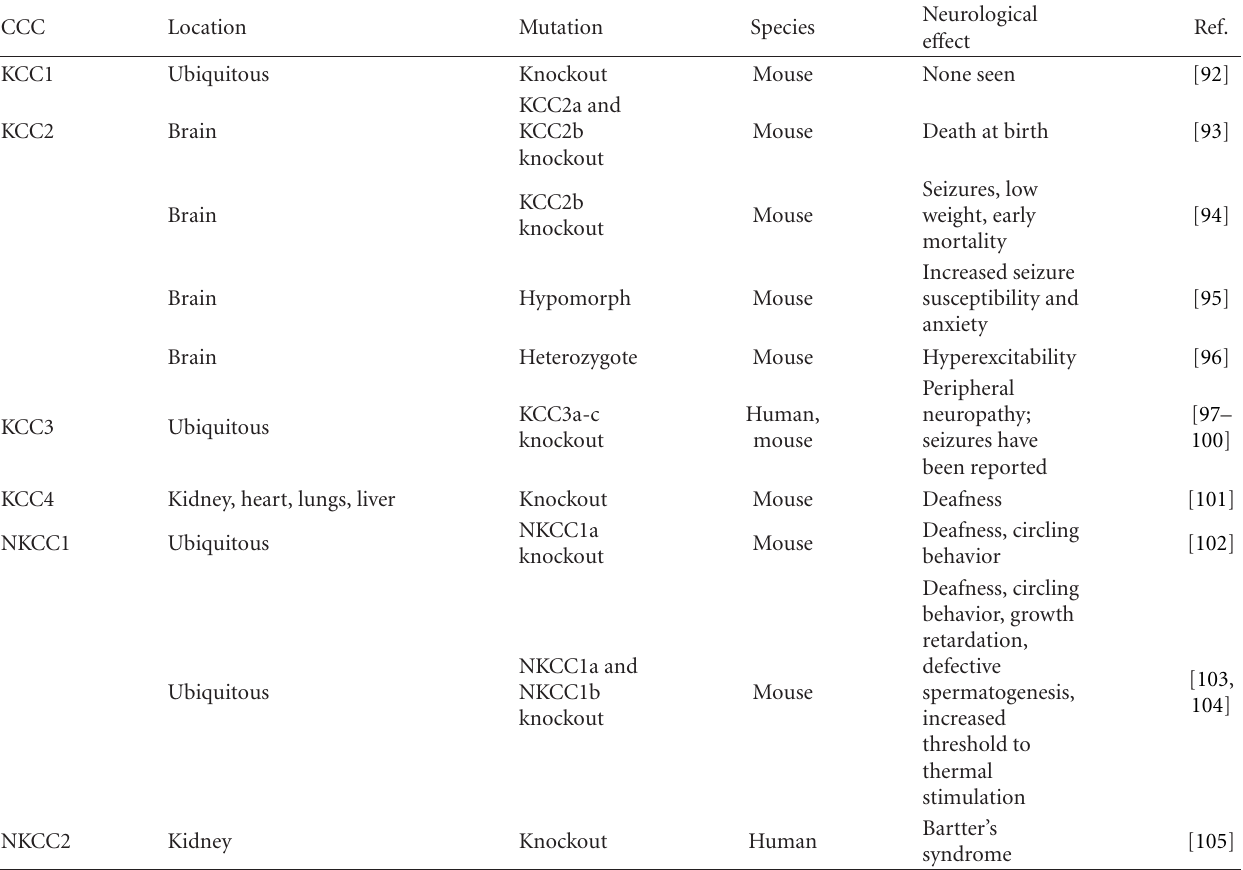
Table 2: Phenotype of CCC